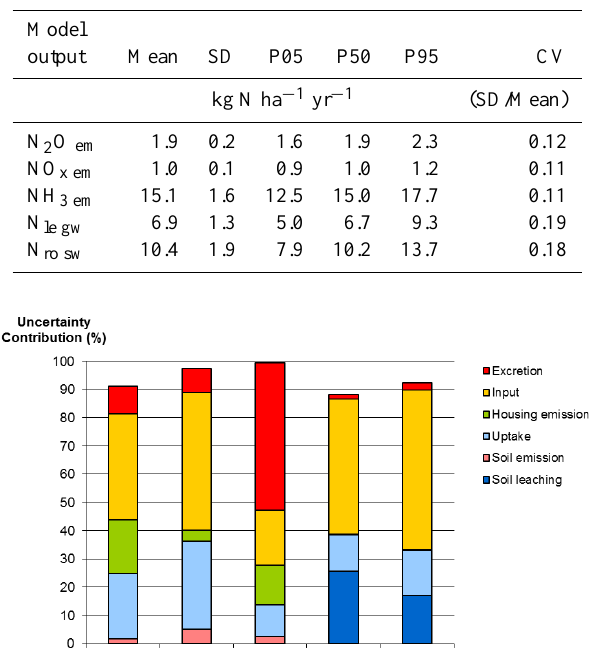
Table 5. Overall uncertainty at EU27 level, expressed as mean and